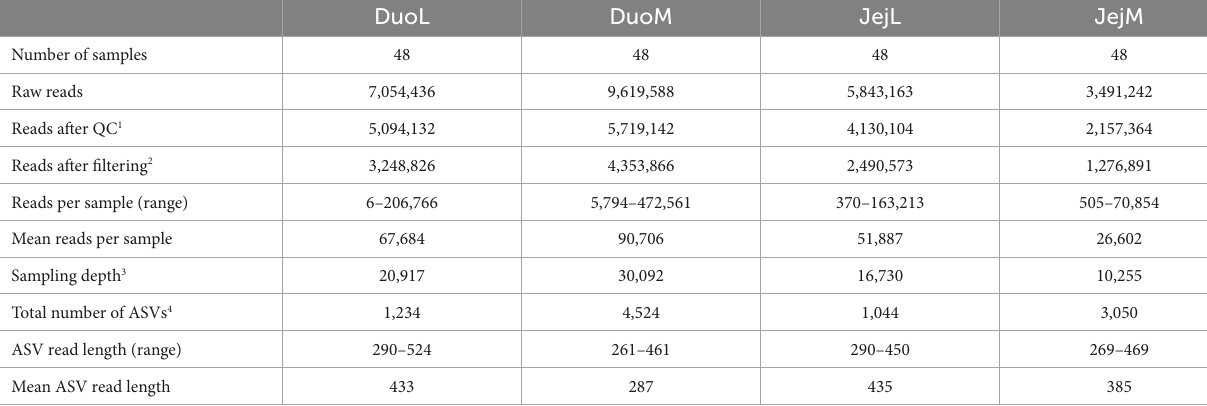
TABLE 1 Sequencing summary of the four microbiota datasets processed in QIIME